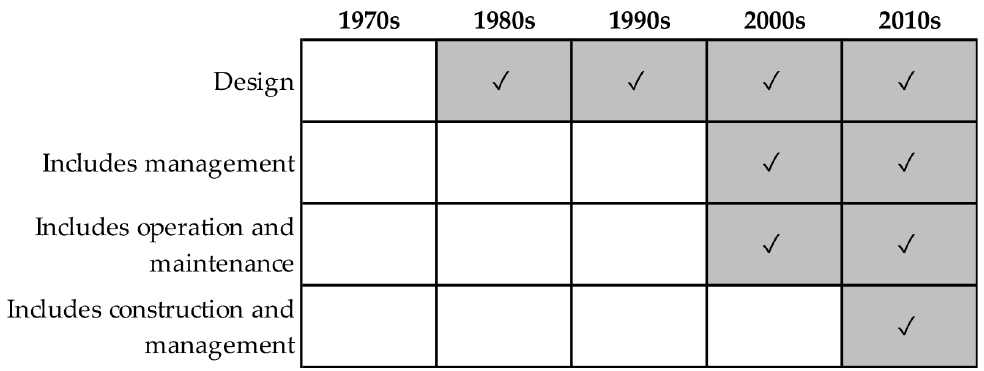
Figure 8. The trend of the inclusion of workflow stages in the evaluation objects indicated by defi- nitions.